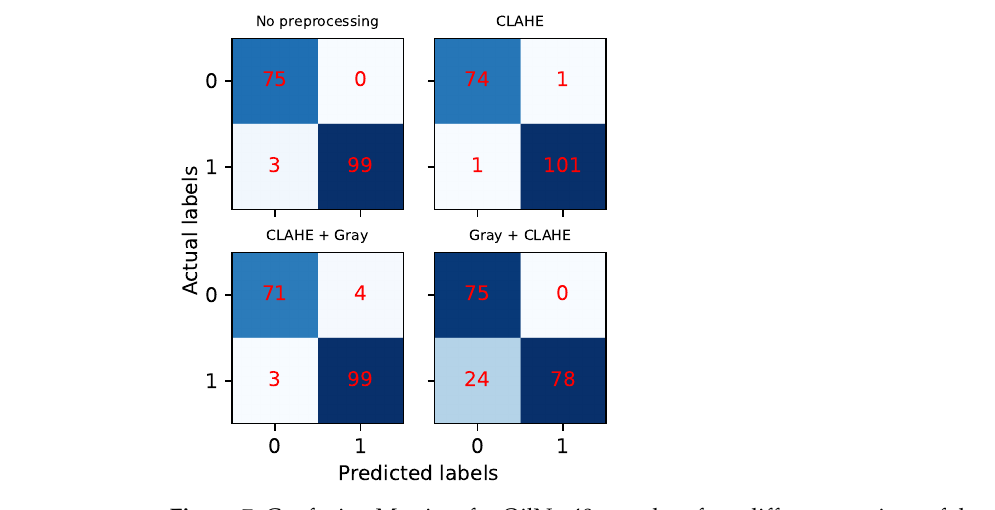
Figure 7. Confusion Matrices for OilNet40 tested on four different versions of the test dataset. The outcomes confirm the results of the training for the color images. In the case of grayscale images, OilNet40 trained on CLAHE + gray dataset seems to perform better than gray + CLAHE even though the training suggested the